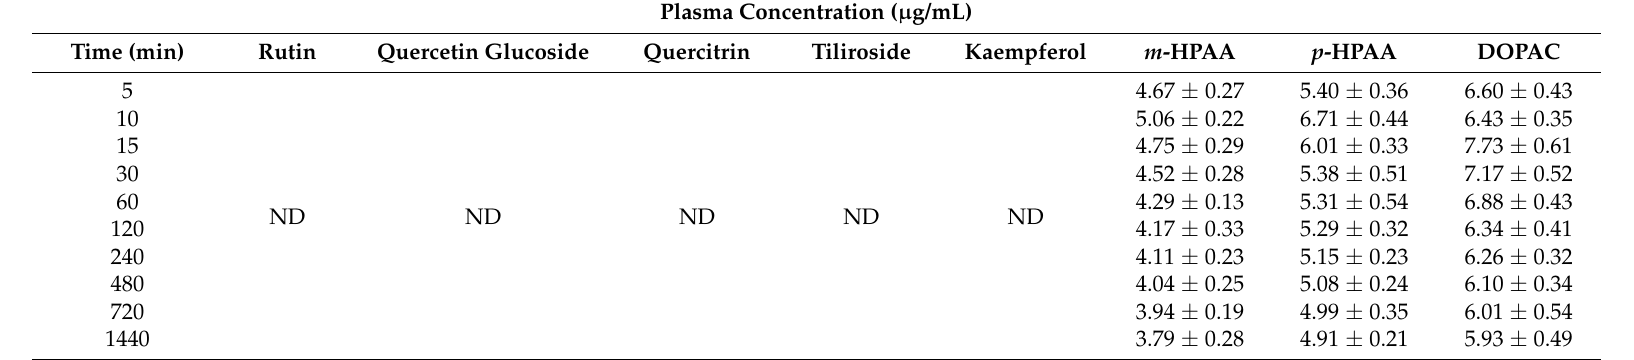
Table 2. Variation in plasma concentration of the flavonoid biotransformation products in the first 24 h after the oral administration of a single dose of 200 mg/kg of the anxiolytic